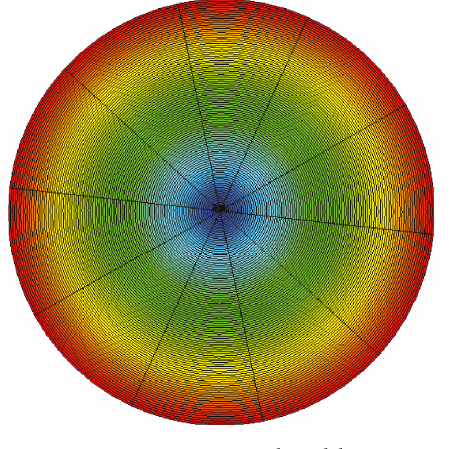
Figure 4: Numerical model. Table 2: Basic parameters of numerical model.